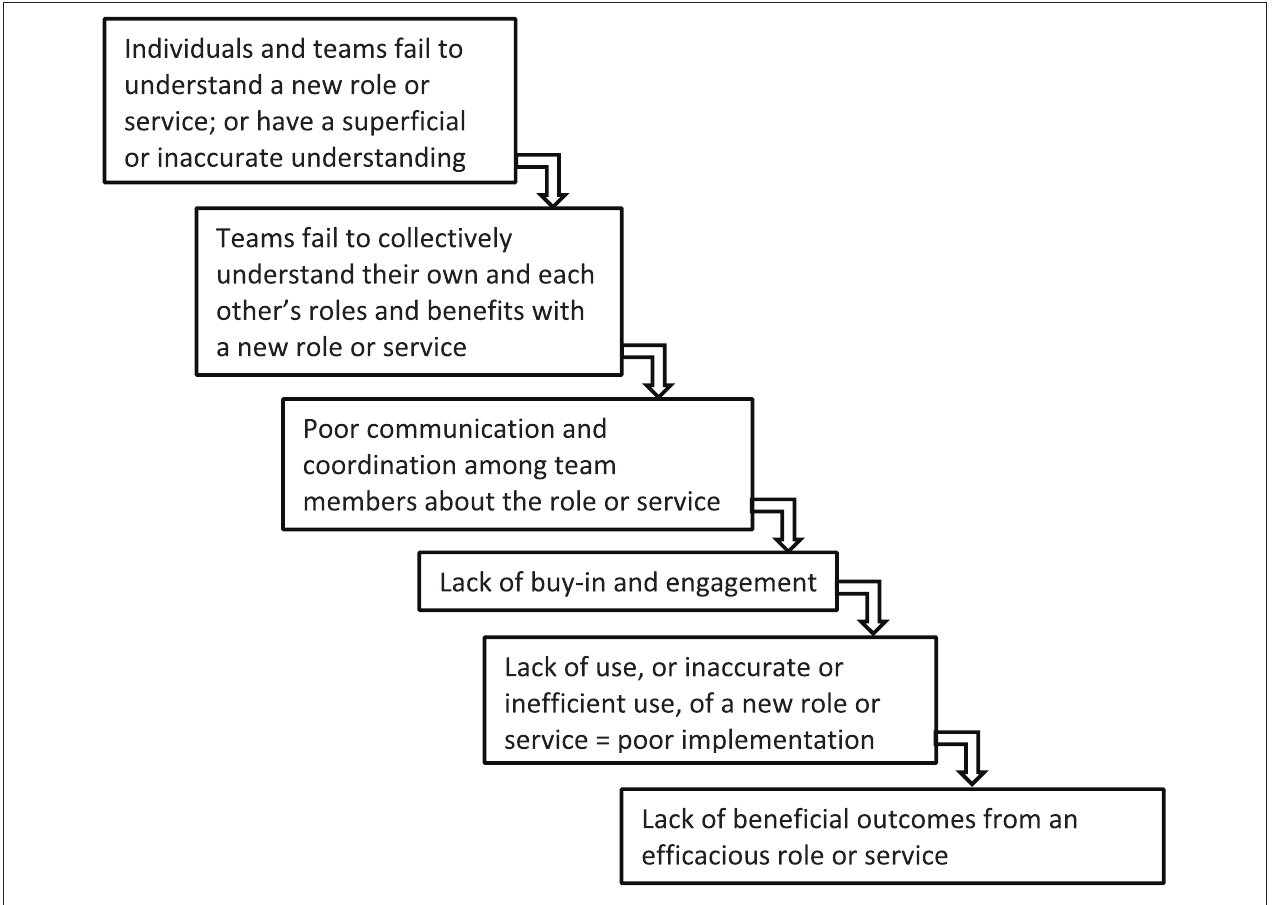
FIGURE 1 | Potential pathway of failed